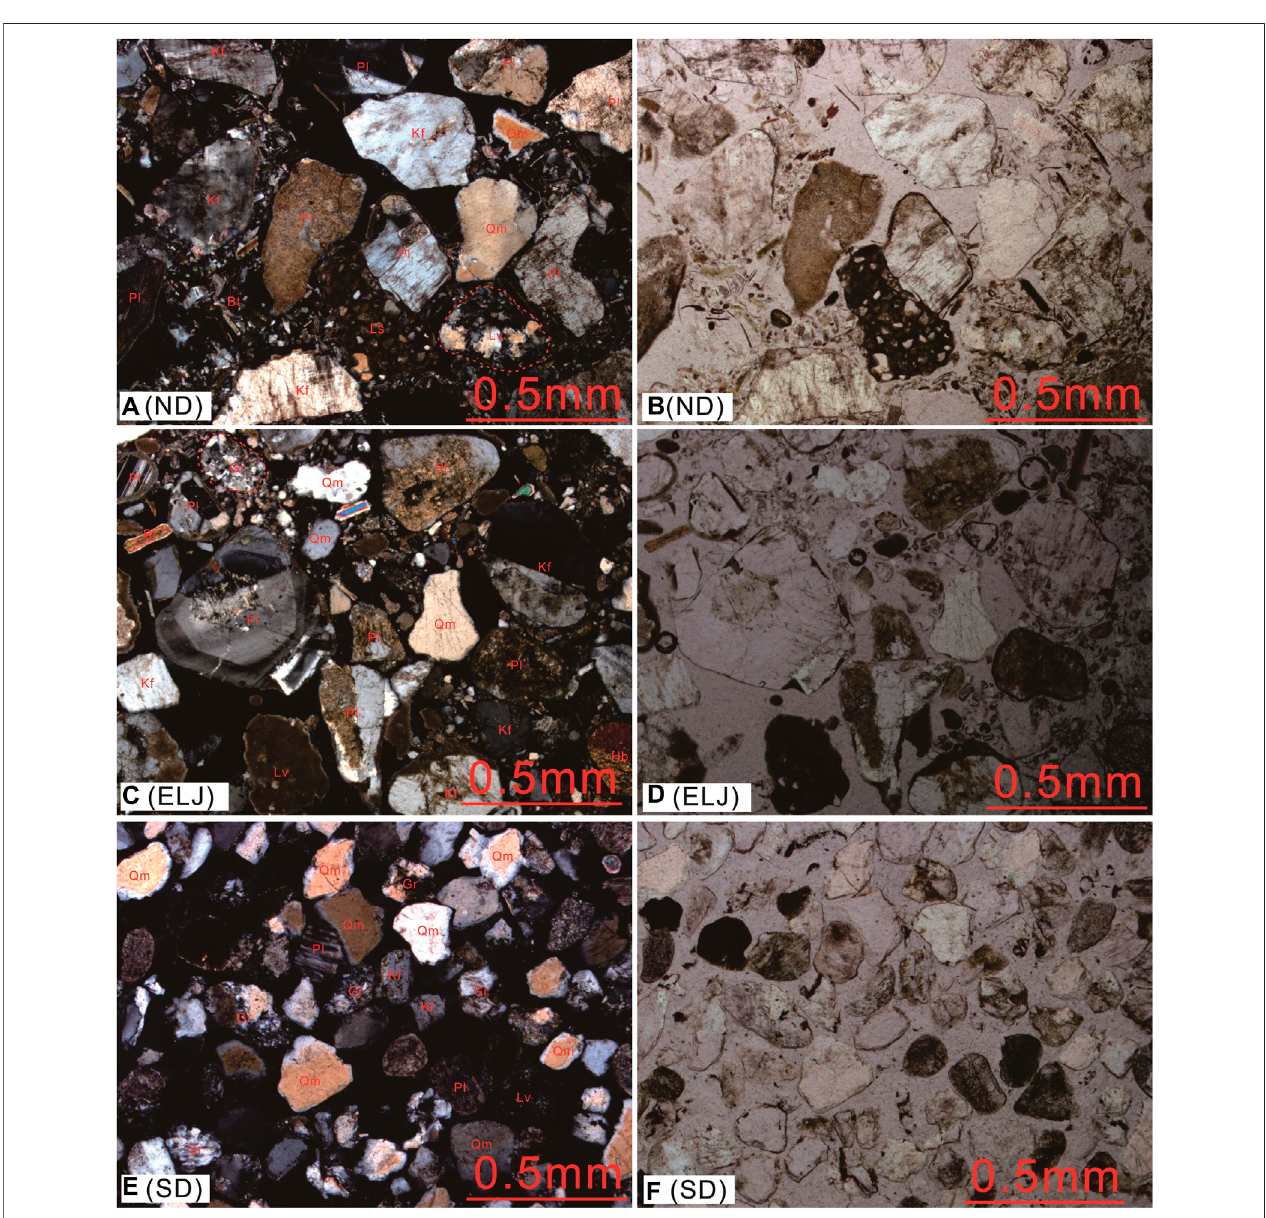
FIGURE 3 | Photomicrographs of the sand sediments from the beach, beach bar, and aeolian sand dune of the Qinghai Lake, cross-polarized light (left) , and plane-polarizedlight (right) . (A,B) SandsfromtheNiaodaobeach(ND). (C,D) SandsfromtheErlangjian beachbar(ELJ). (E, F) Sandsfromtheaeoliansand dune(SD). Qm: monocrystalline quartz, Lv: volcanic fragment, Ls: sediment fragment, Gr: granite fragment, Pl: plagioclase, Kf: K-feldspar, Hb: hornblende, Bt: biotite.